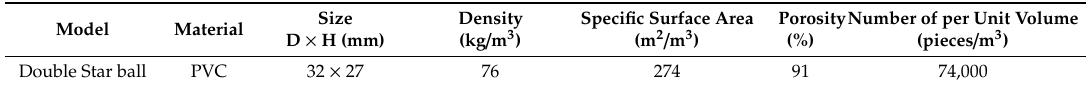
Table 4. Specifications of biological contact filter in model factory (filling rate of biological contact filter in CA tank is 50%).